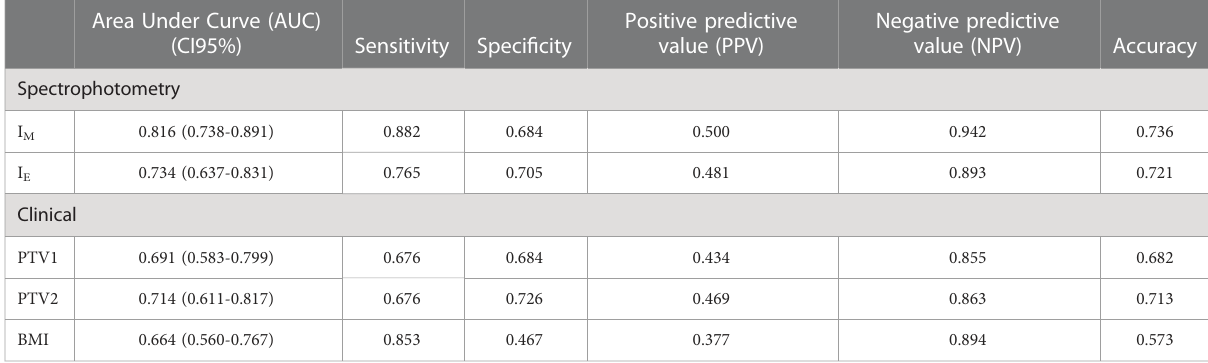
TABLE 2 Detailed diagnostic accuracy statistics for the fi ve quantitative covariates signi fi cantly associated with the toxicity score. Area Under Curve